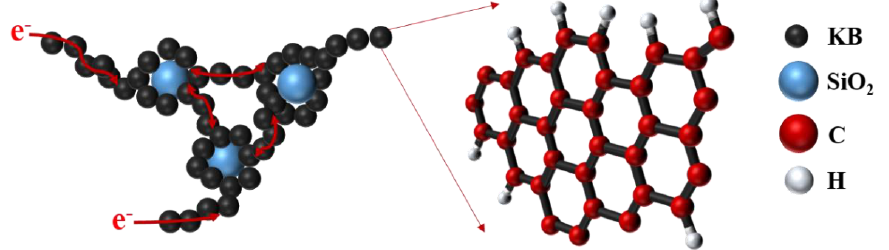
Figure 10. Schematic diagram conductive network of KB.